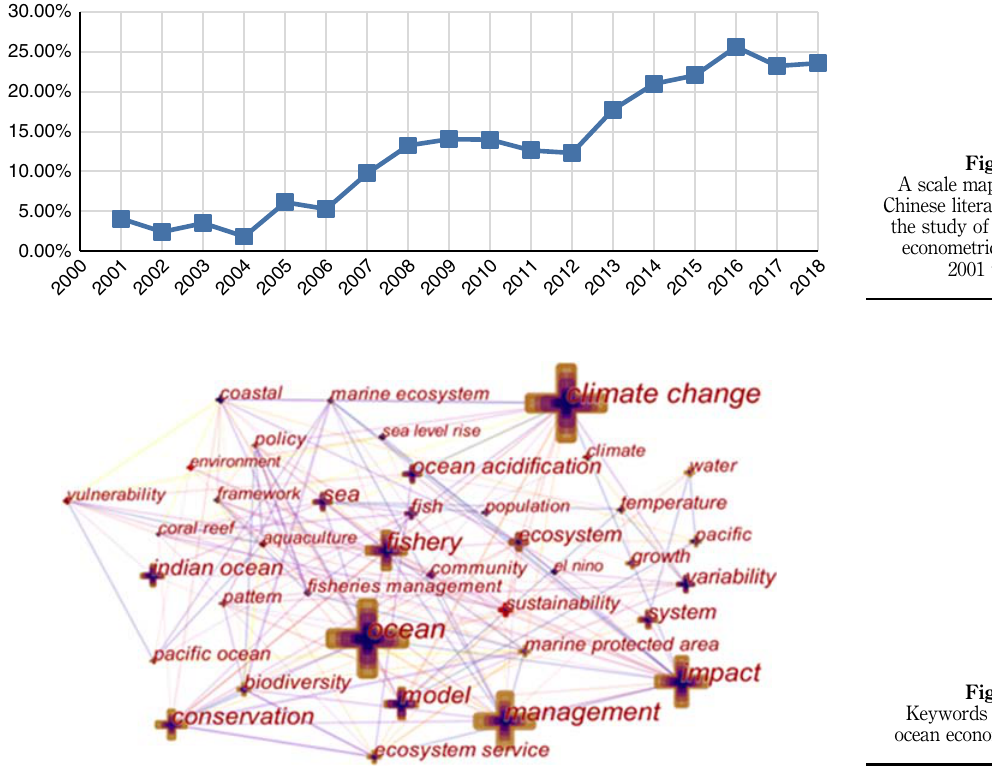
Figure 6. A scale map of the